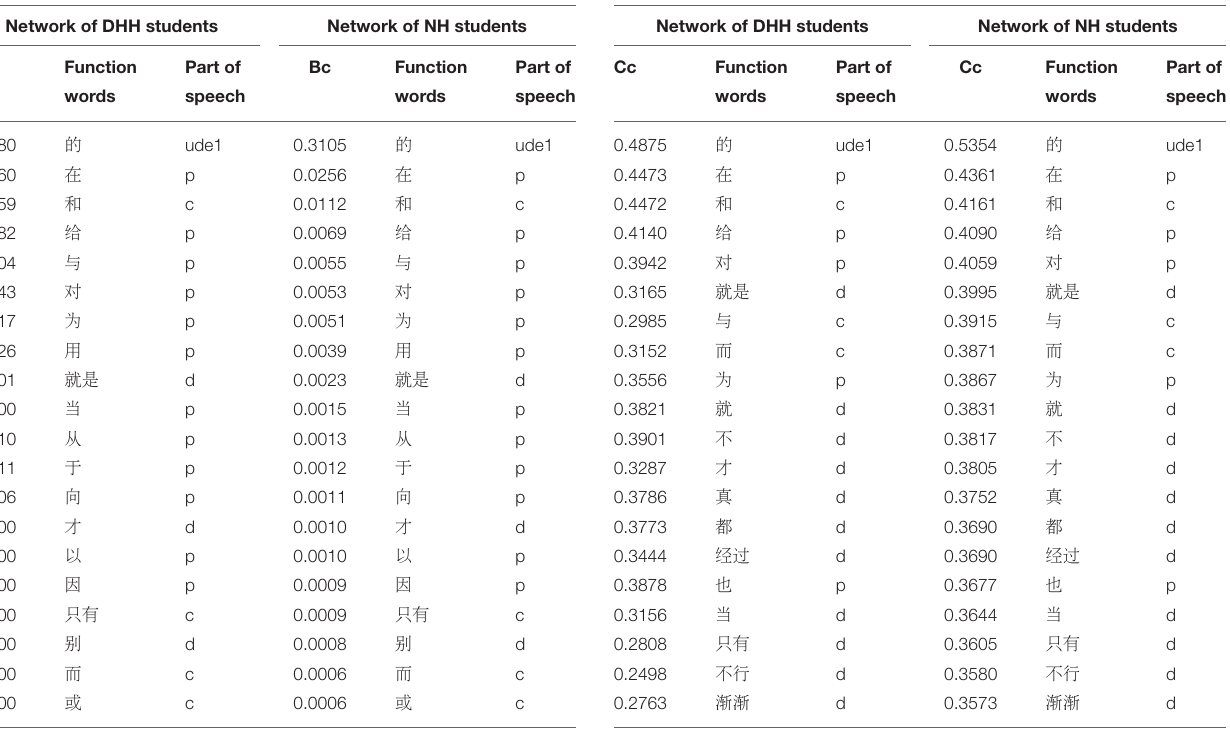
TABLE 6 | Closeness centrality (Cc) of 20 function words in the two